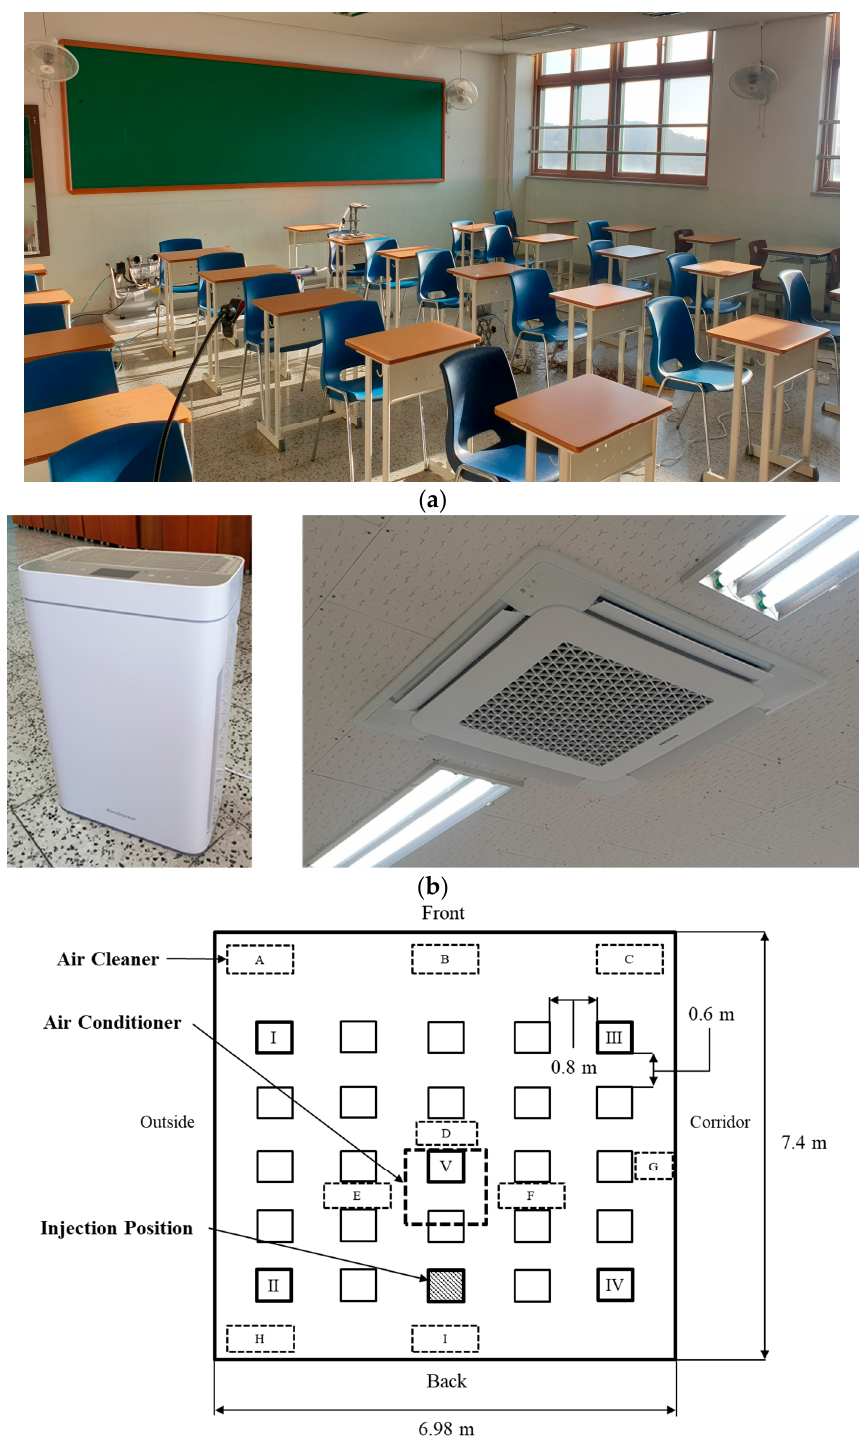
Figure 1. Experimental space selected for the study: ( a ) photograph of the classroom showing the desks and chairs were arranged in a 5 × 5 matrix; ( b ) photographs of the air purifier and the ceiling-type air conditioner installed in the room; ( c ) floor plan of the classroom.